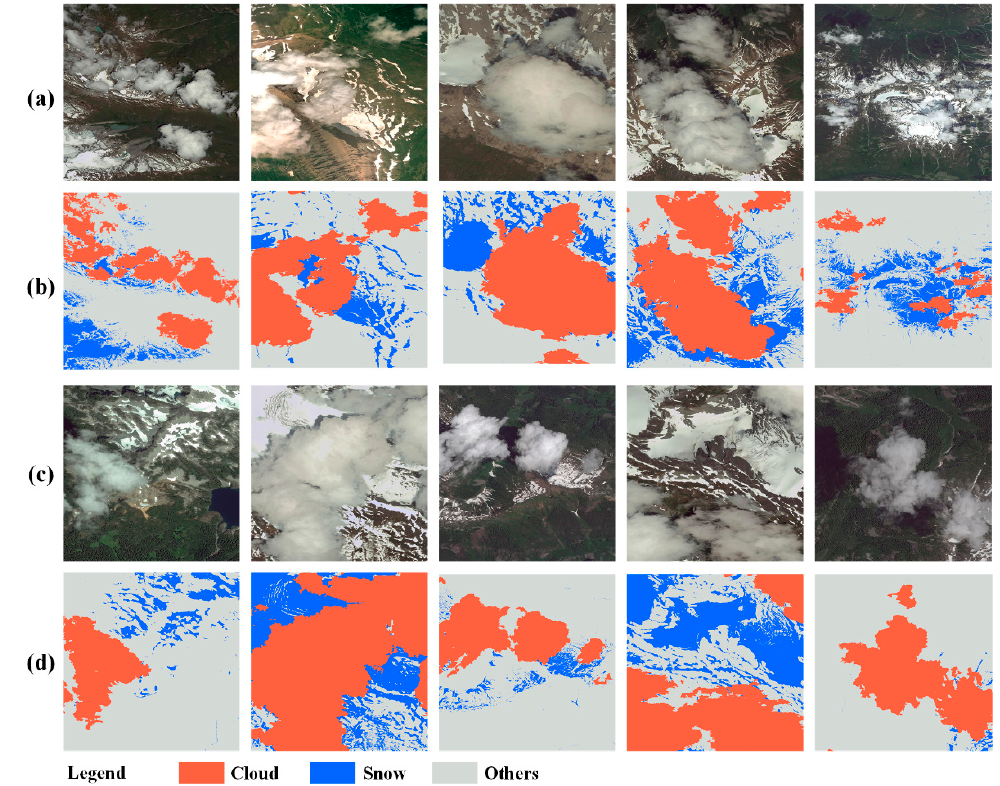
Figure 5. Some annotation samples from CSWV. ( a , b ) The original images and corresponding masks of CSWV_M21. ( c , d ) The original images and corresponding masks from CSWV_S6. The red regions represent clouds, the snow is represented by the blue regions, and the gray regions are the other